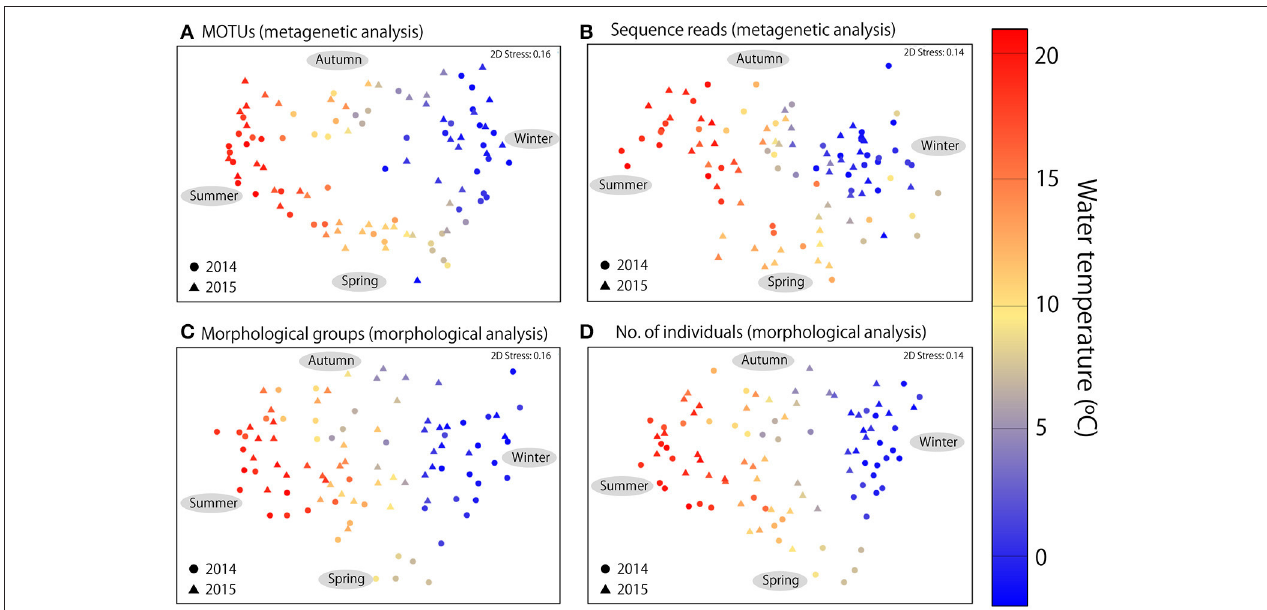
FIGURE 4 | Multidimensional scaling ordination of zooplankton communities. (A) Metagenetic analysis based on presence/absence of MOTUs in samples. (B) Numbers of molecular taxonomic unit (MOTU) sequence reads per sample. (C) Morphological analysis based on presence/absence of morphological groups. (D) Numbers of individuals detected in morphological groups per sample. Proportions of sequence reads and numbers of individuals were log x + 1 -transformed in abundance-based analyses, and similarities were calculated using the Bray–Curtis similarity index. The color of each sample indicates mean water temperature.